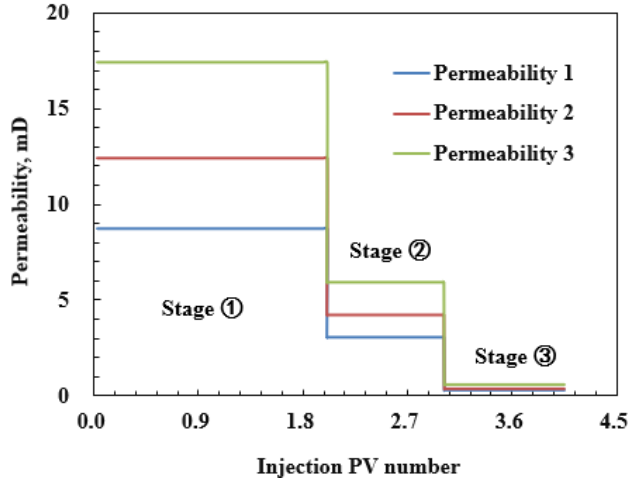
Figure 10. Permeability curve of 0.50 wt % HR9806 + 0.15 wt % crosslinker plugging experiment.